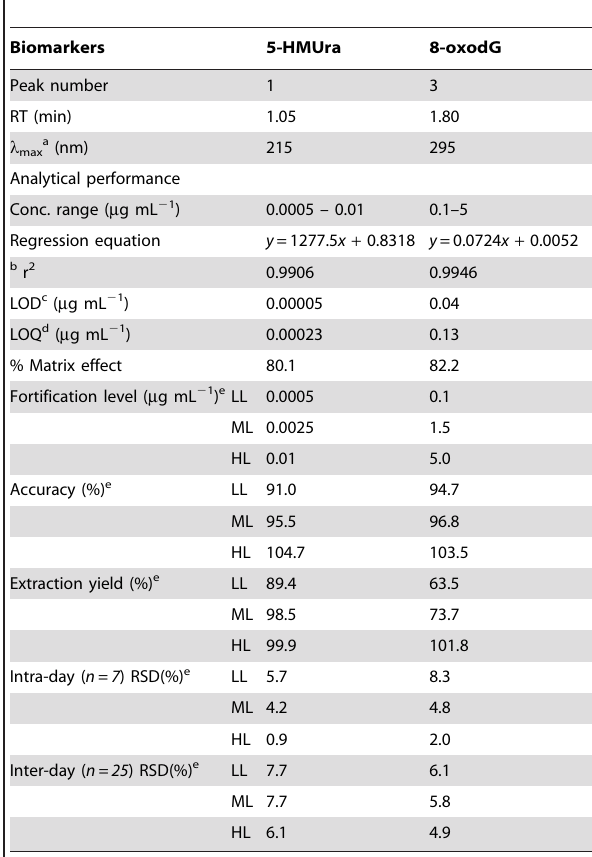
Table 2. Figures of merit of the newly developed eVol H - MEPS/UPLC-PDA